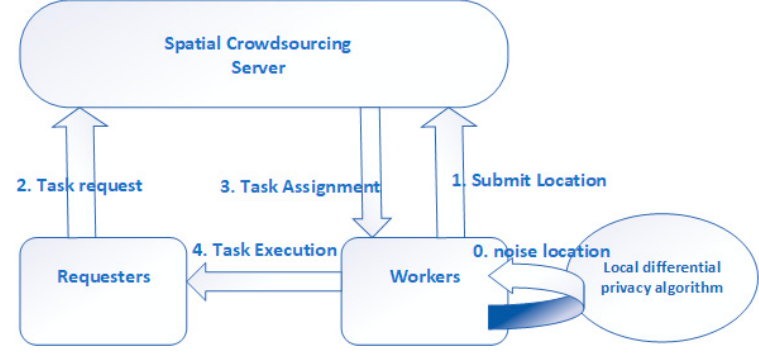
Figure 2. Privacy protection framework.